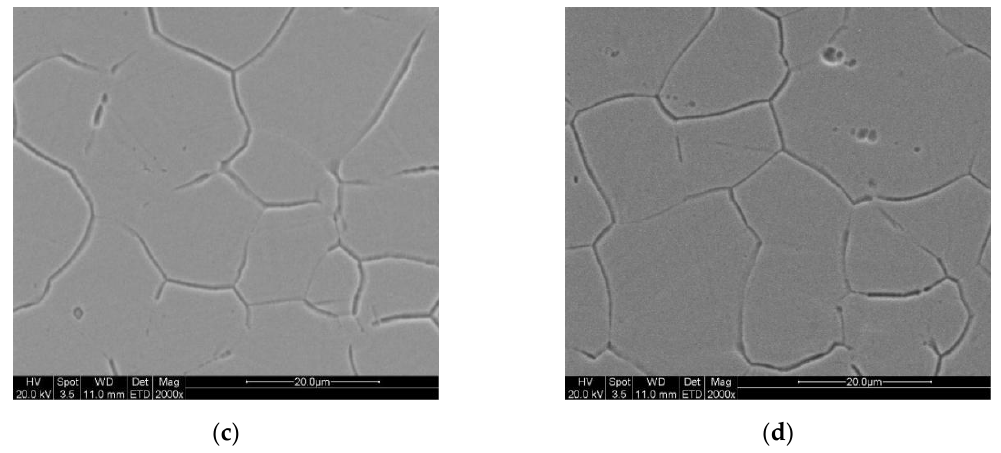
Figure 8. SEM images observed on the surfaces of bare and colored films formed by coloring solutions with different NiSO 4 concentration: ( a ) blank; ( b ) 0.2 g·L − 1 ; ( c ) 0.3 g·L − 1 ; ( d ) 0.4 g·L − 1 . Table 4. Element composition (wt %) measured on colored specimens’ surfaces.